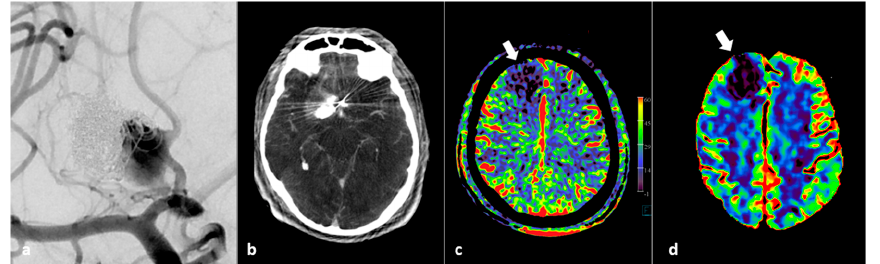
Figure 6. FD CT PBV imaging in a 46-year-old patient with thrombo-embolic and hemorrhagic complications during flow diverter placement. ( a ) AP view DSA image pre-intervention shows a significant neck remnant after previously coiled pericallosal aneurysm. ( b ) FD CT axial MIP reformation after occurrence of complications shows local hematoma and contrast. ( c ) Post PVO FD CT imaging shows right frontal residual wedge shaped perfusion deficit (white arrow). ( d ) Follow-up conventional MD CT CBV perfusion confirms local perfusion